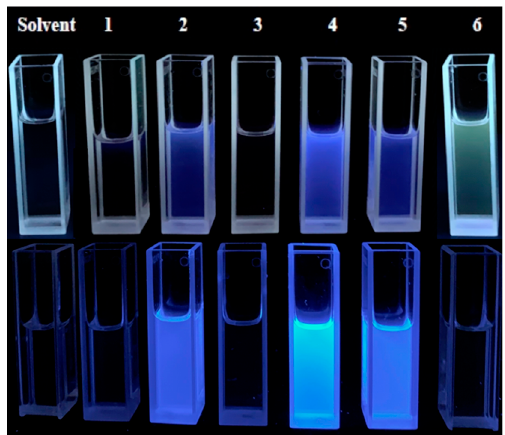
Figure 6. Emission photographs of solvent THF (most left) and 1 – 6 in THF, excited at 254 nm (top) and 365 nm (bottom), were recorded at room temperature in air.